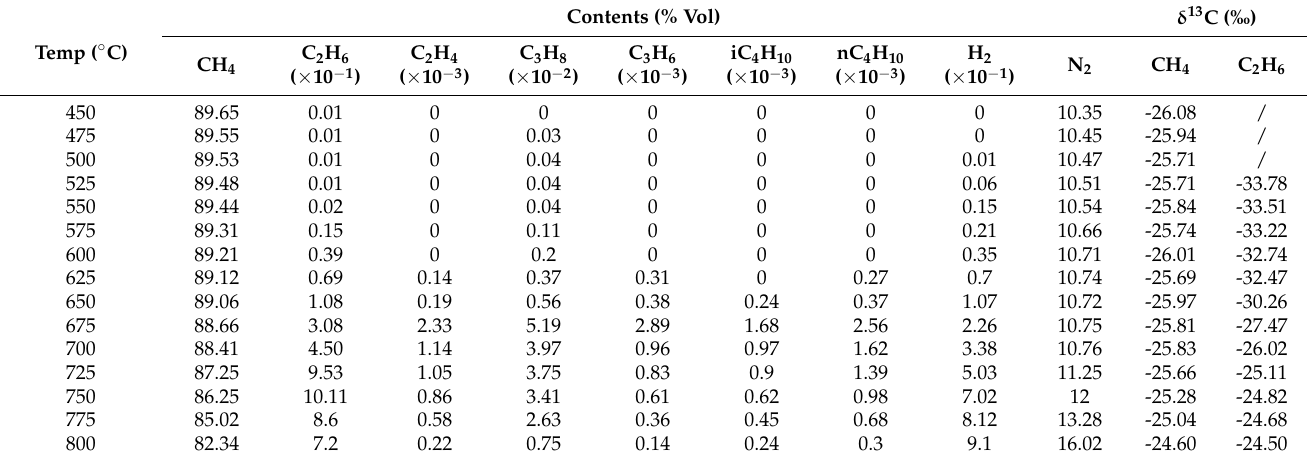
Table 1. Components and carbon isotopes of gaseous products at different temperatures.